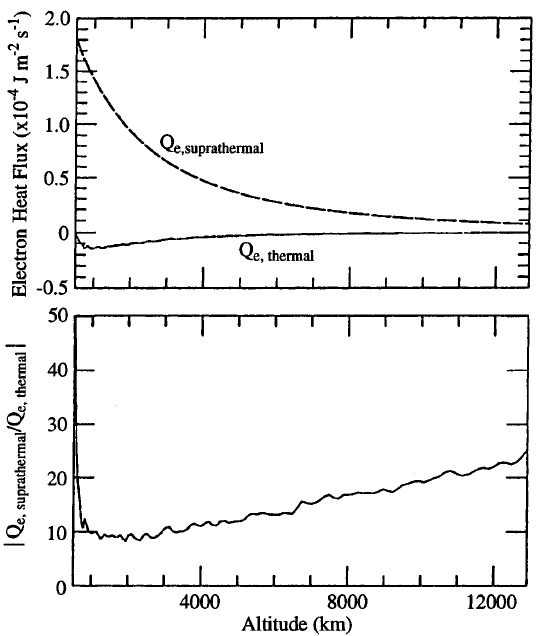
Fig. 7. Top panel : heat fluxes carried by the thermal electrons ( Q e ; thermal (cid:134) and photoelectrons ( Q e ; suprathermal (cid:134) . Note that the heat flux contribution by the thermal electrons is in the downward direction ( negative sign ) while that by the photoelectrons is upwardly directed ( positive sign ). Bottom panel : the ratio of the magnitudes of the two heat fluxes Fig. 8. Total heat flux profile for the total